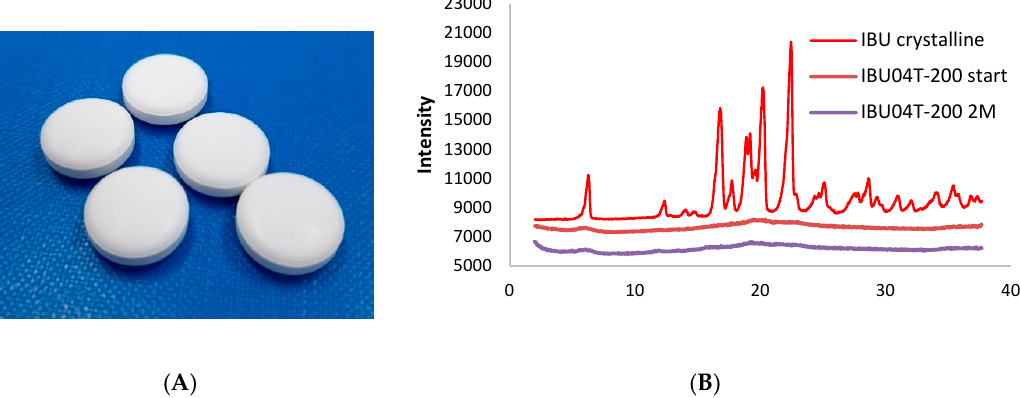
Figure 7 . ( A ) Tablets containing IBU–Neusilin extrudates, ( B ) XRPD diffractograms of IBU tablets at different time points, stored in 40 °C/75% RH in PVC blisters after two months (violet line). The XRPD diffractogram indicated that an amorphous IBU impregnated into Neusilin structures